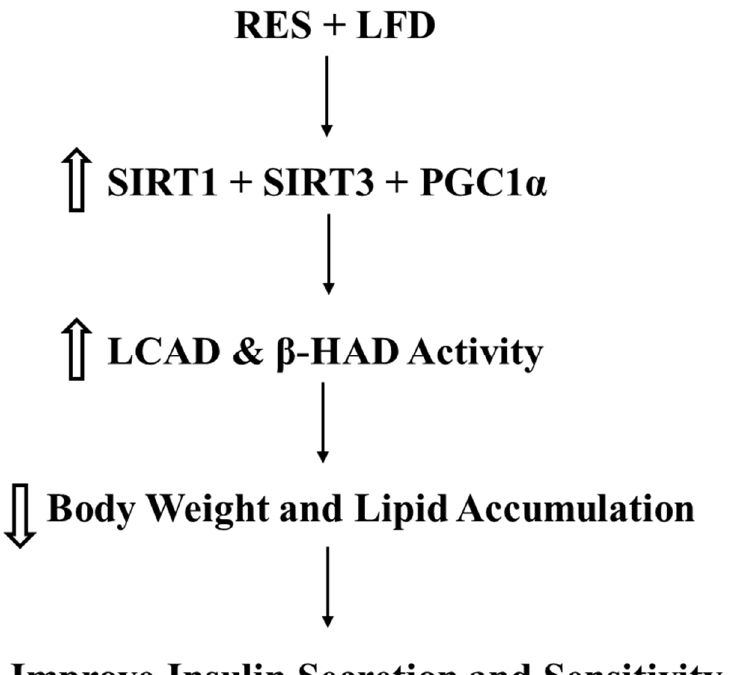
Figure 5. Model for the mechanism of action of resveratrol and diet on glucose and lipid metabolism.